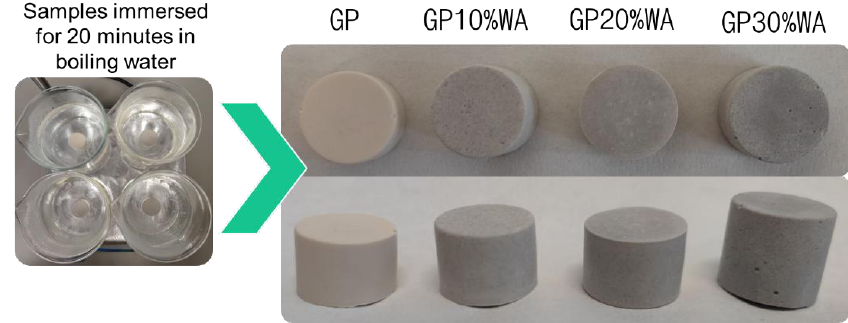
Figure 7. Image showing the result of the boiling water test.